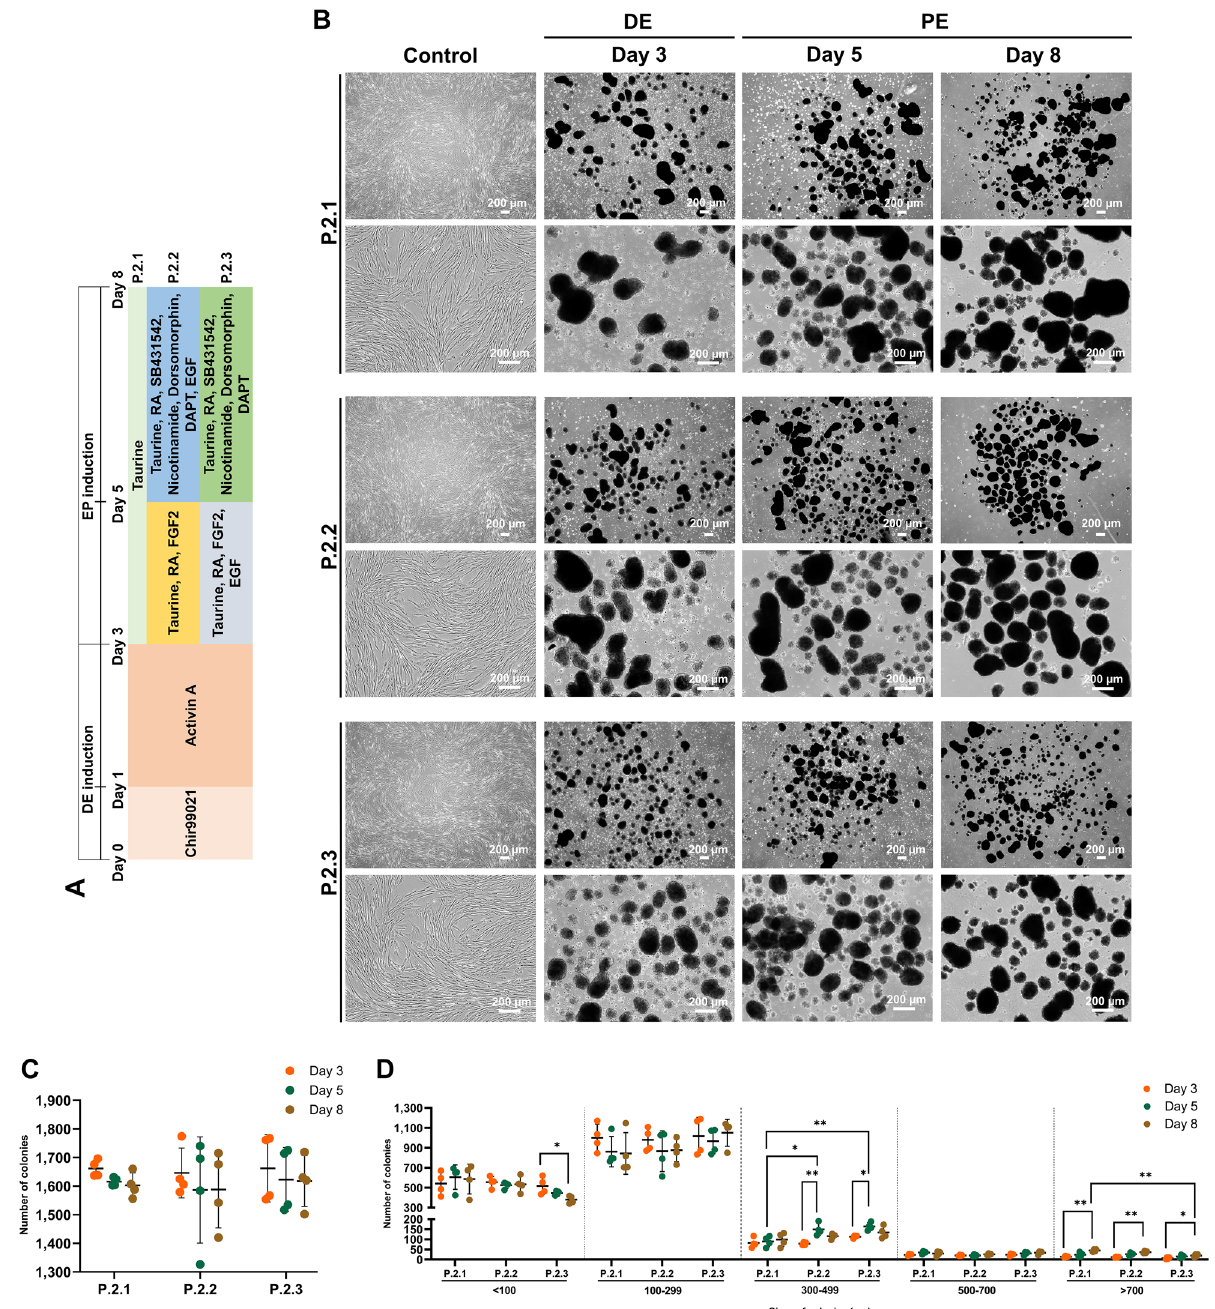
Figure 3. Generation of cAD-MSC-derived PE cells. The diagrams of three protocols used for the induction of cAD-MSC-derived PE cells are shown in ( A ). Differentiation of morphological appearances of cAD-MSCs toward PE cells was observed at day 3, 5 and 8 ( B ). The total colony number ( C ) and the distribution of colony sizes ( D ) were evaluated. Bars indicates the significant differences (*, p value < 0.05; **, p value <